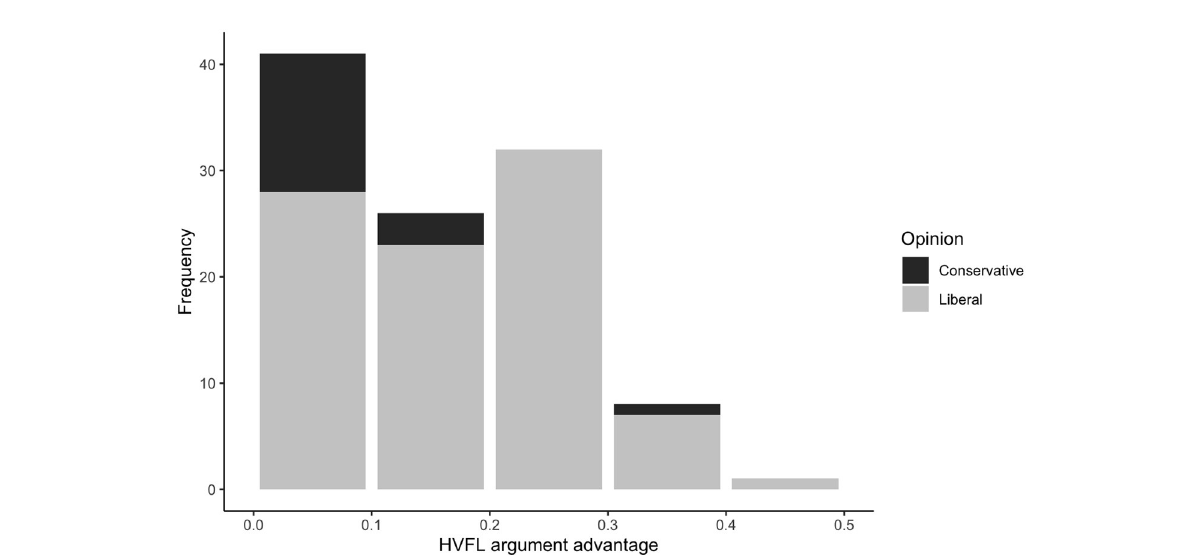
FIGURE2 The distribution of the HVFL argument advantage for 27 moral opinions in the American National Election Studies and 81 moral opinions in the General Social Survey (reverse coded in case the stated opinion was disadvantaged). Each bar of the histogram shows the number of opinions for which the advantage fell in the corresponding interval. The gray part of each bar indicates the proportion of opinions that were liberal opinions, that is, were more common among liberals than among conservatives in the American National Election Studies/General Social Survey data.